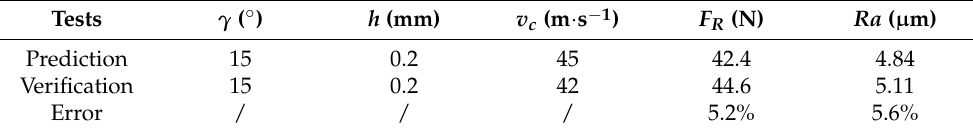
Table 9. Optimization and verification of resultant force and surface roughness.